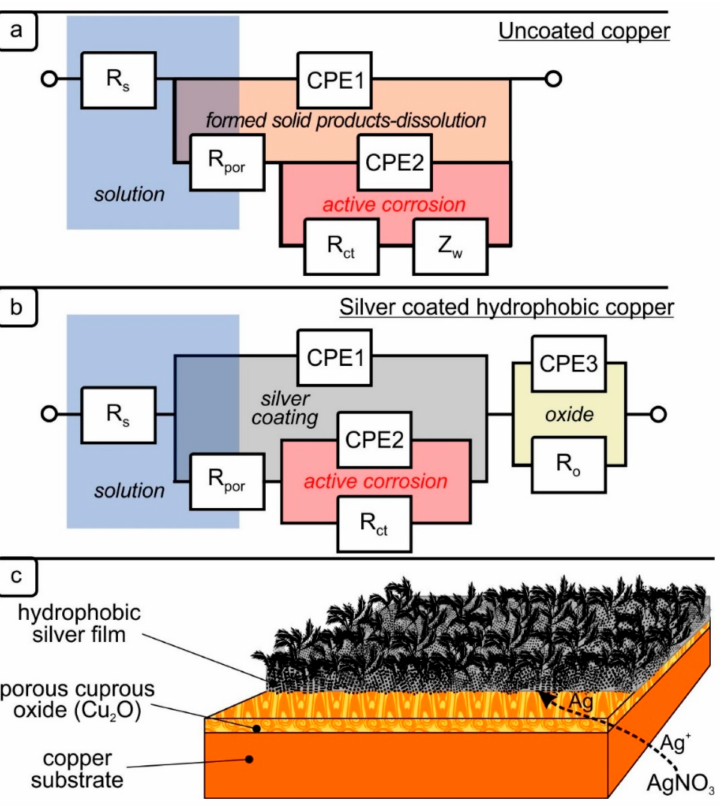
Figure 9. Proposed equivalent circuit representing the corrosion behavior of ( a ) uncoated copper and ( b ) silver-coated hydrophobic copper. ( c ) Schematic illustration of the silver coating structure used for representing the corrosion behavior of hydrophobic